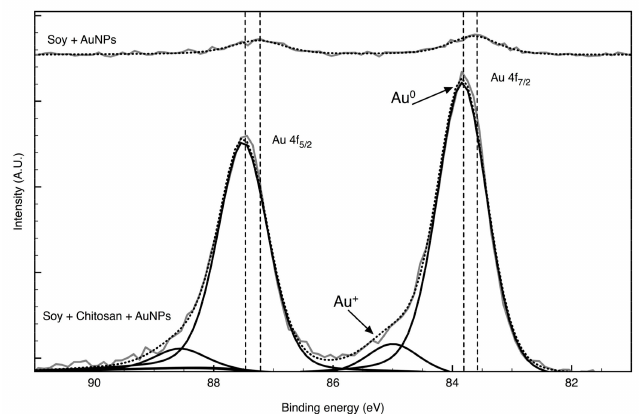
Figure 5. High-resolution deconvoluted XPS spectra with relative areas of the Au4f binding energy region on soybean fibres functionalized with AuNPs before and after chitosan